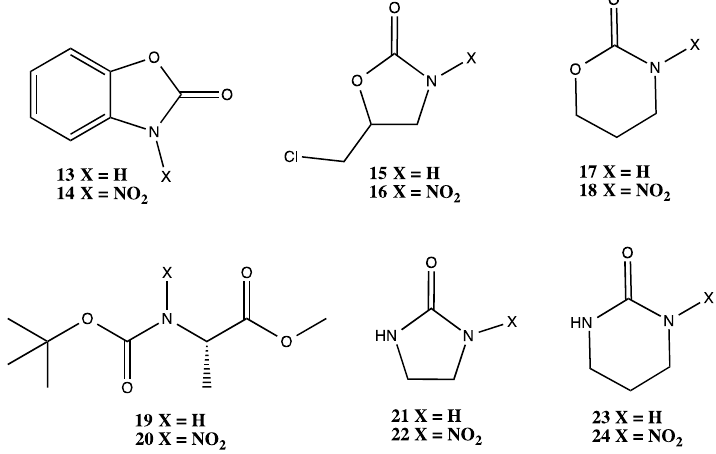
Figure 1. Structure of carbamates and cyclic urea derivatives.